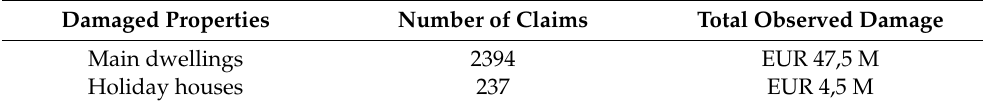
Table 1. The available dataset in terms of single claims and observed economic